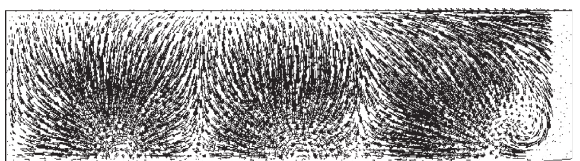
Figure 7: 2-2 plane velocity vector diagram with 45 ° lateral